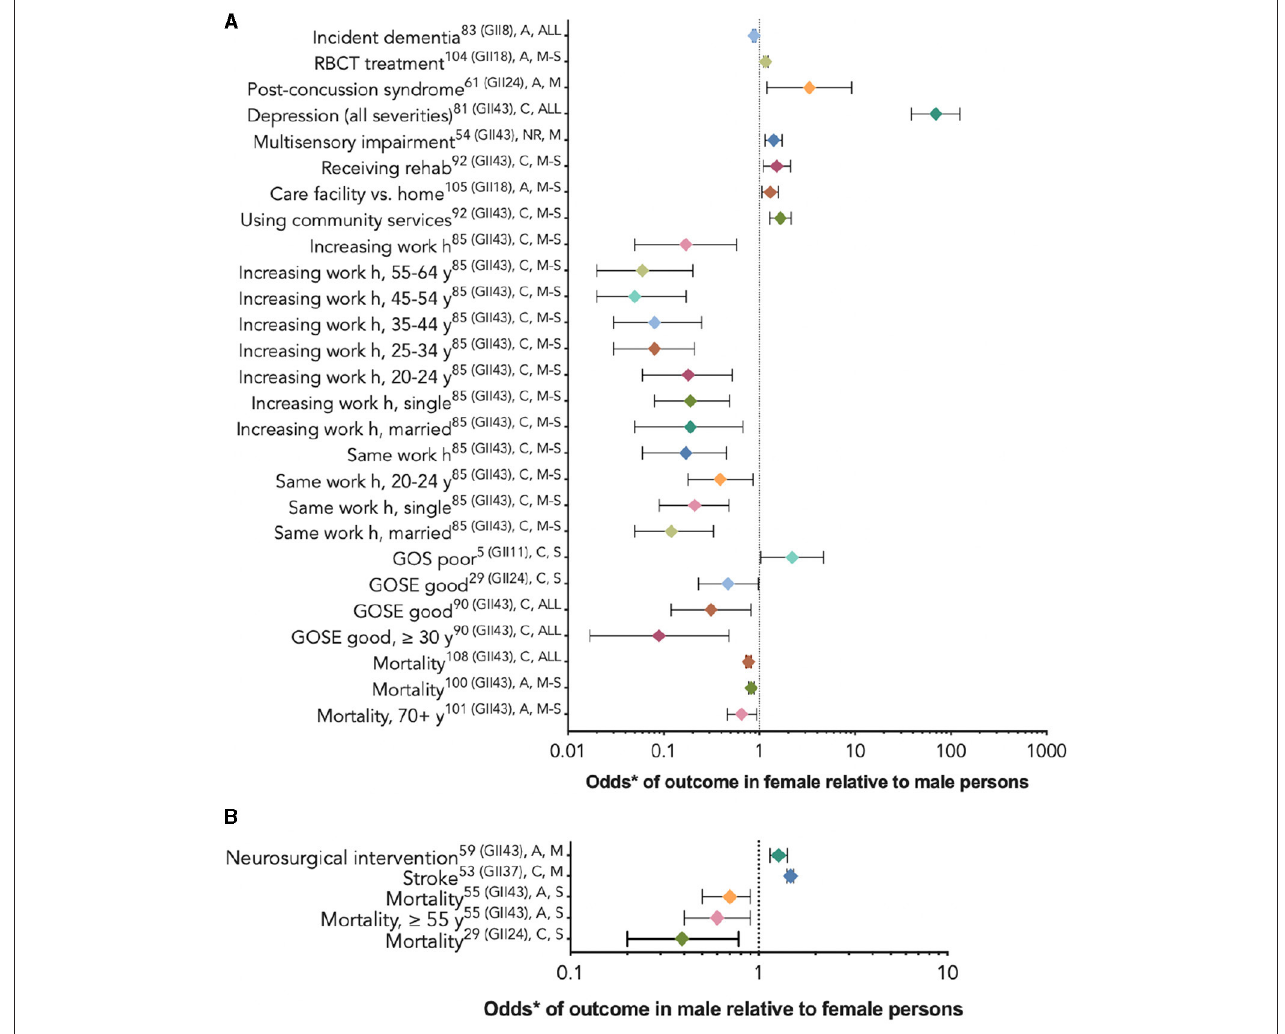
FIGURE 4 | Statistically significant sex/gender-related results reported as OR/RR/HR (CI). *The RBCT treatment and dementia outcome studies reported risk ratios (A) , the stroke outcome studies reported hazard ratios (B) , and the rest reported odds ratios. (A) The outcome odds for female relative to male persons. (B) The outcome odds for male relative to female persons. The error bars represent a 95% confidence interval. The superscript letters indicate the GII rank of the country where the study was conducted (lower rank indicates lower gender inequality), the post-injury phase (A, acute; C, chronic; and NR, not reported), and injury severity (M, mild; M-S, moderate-to-severe; S, severe; and ALL, all severities). GII, Gender Inequality Index; RBCT, red blood cell